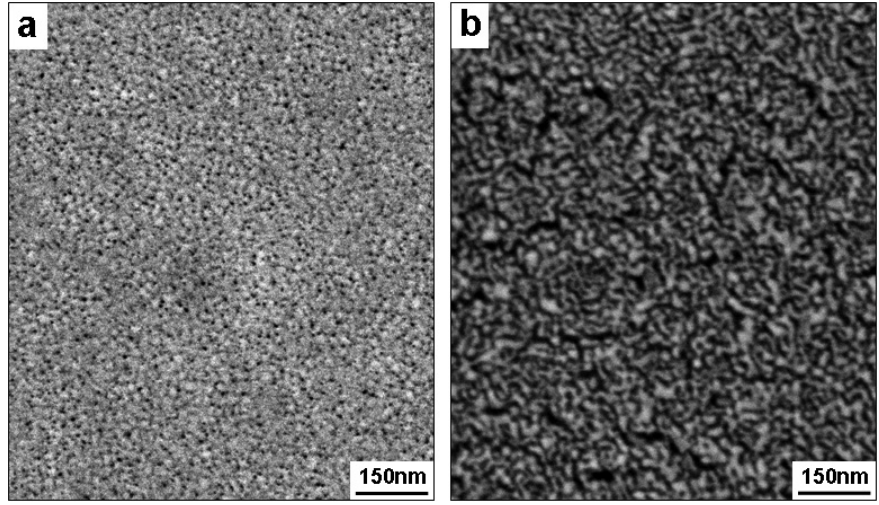
Figure 5. Microstructure of np-Pd obtained from 90 nm PdNi films dealloyed in (a) concentrated (98%) and (b) dilute (25%) sulfuric acid solutions. The films exhibit particle- like and sponge-like structures, respectively, with cluster/ligament size on the order of 10